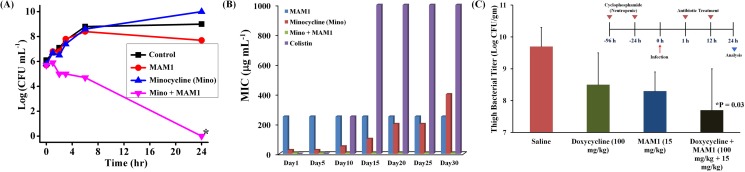
Synergy, resistance development and in-vivo antibacterial efficacy of MAMs and tetracycline antibiotics against bla
NDM-1
E. coli (R3336).(A) The combination of MAM1 and minocycline (50 μg mL-1 + 6.3 μg mL-1) showed synergistic bactericidal activity whereas MAM1 (50 μg mL-1) alone and minocycline alone (6.3 μg mL-1) were devoid of antibacterial activity (star represents < 50 CFU mL-1, the detection limit of the experiment). (B) Bacteria developed resistance to minocycline alone with increase in MIC up to 400 μg mL-1 whereas it did not develop resistance to minocycline (6.2 μg mL-1) in presence of MAM1 (50 μg mL-1) up to 30 days. Bacteria did not readily develop resistance to MAM1 whereas it developed resistance to colistin with an increase in MIC up to 1000 μg mL-1. (C) In-vivo antibacterial efficacy of MAM1 and doxycycline in mice models. The bacterial burden in the thighs of the mice (4 mice in each group) were determined and expressed as mean ± S.E.M (standard error of mean). P value was calculated using the unpaired Student’s t test (2 tailed 2 samples assuming equal variances) and a value P < 0.05 was considered significant. *P = 0.03 between the saline treated and combination treated samples (Inset shows the experimental design).